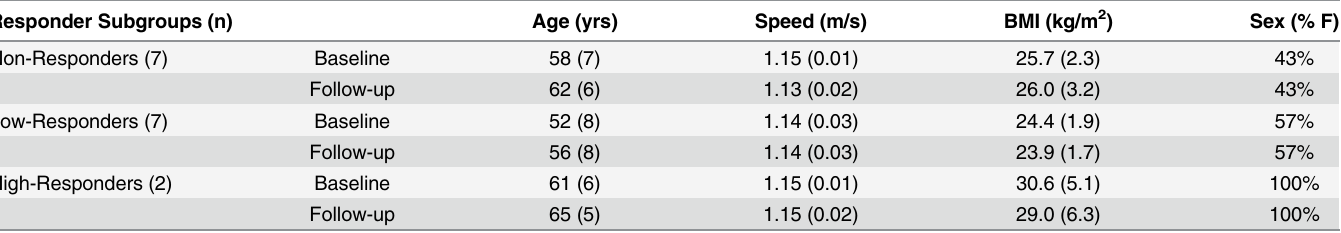
Table 2. Means (SD) of demographics for 3 – 4 follow-up patients (n = 16) at baseline at 3.5 ( ± 0.3) years following their involvement in the study. Responder Subgroups